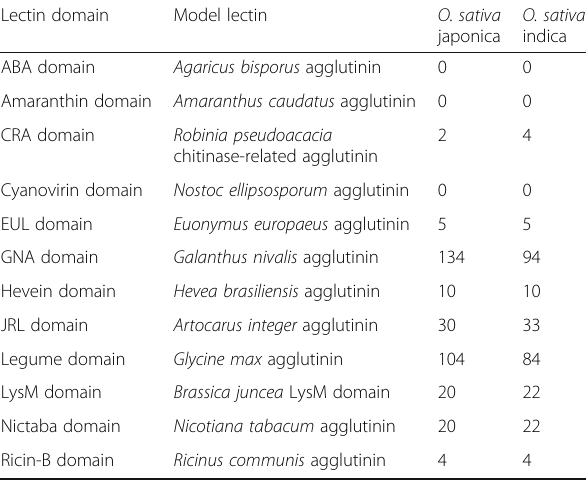
Table 1 Predicted lectin genes in the Oryza sativa genome Lectin